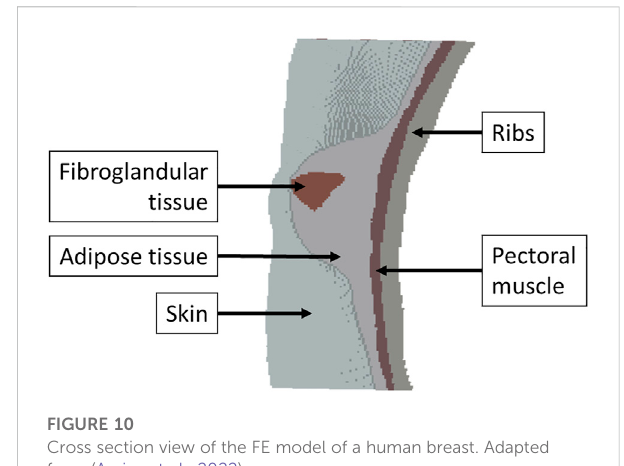
FIGURE 10 Cross section view of the FE model of a human breast. Adapted from (Areias et al., 2022)